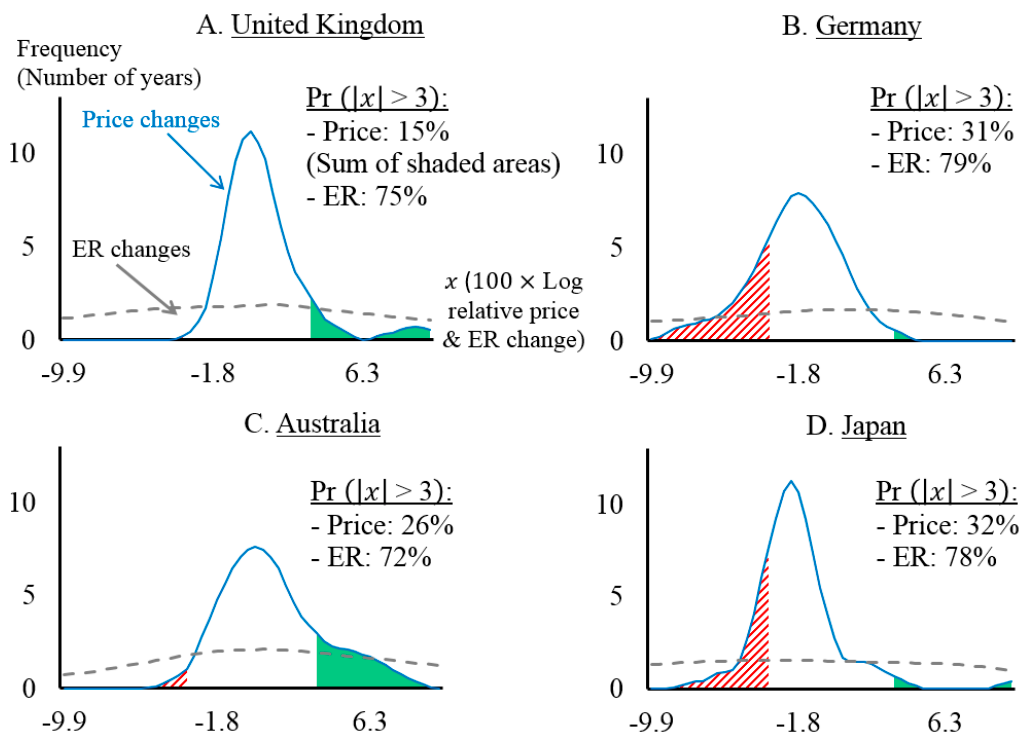
Figure 1. Price and Exchange-Rate Volatilities in the Post Bretton-Woods Era. Notes: Each panel presents the densities of 𝑥 (cid:3030),(cid:3047) = 100 × (𝑙𝑜𝑔𝑋 (cid:3030),(cid:3047) − 𝑙𝑜𝑔𝑋 (cid:3030),(cid:3047)(cid:2879)(cid:2869) ) (𝑡 = 1974, … , 2018) (𝑋 (cid:3030),(cid:3047) = 𝑆 (cid:3030),(cid:3047) 𝑜𝑟 𝑋 (cid:3030),(cid:3047) = 𝑅 (cid:3030),(cid:3047) = 𝑃 (cid:3030),(cid:3047) /𝑃 (cid:3022)(cid:3020),(cid:3047) ) , where 𝑆 (cid:3030),(cid:3047) denotes the cost of 1 USD in country c’s currency and 𝑅 (cid:3030),(cid:3047) denotes relative prices, defined as the price level, proxied by the CPI of country c ( 𝑃 (cid:3030),(cid:3047) ), deflated by that of the US ( 𝑃 (cid:3022)(cid:3020),(cid:3047) ). The sample period for the Deutsch Mark ends in 1998. To aid presentation, extreme values are not shown. The figures presented in these plots indicate the proportion of relative-price and exchange-rate changes that are greater than 3%, respectively. Source: (Vo 2019); (International Monetary Fund 2019) and authors’ calculations.